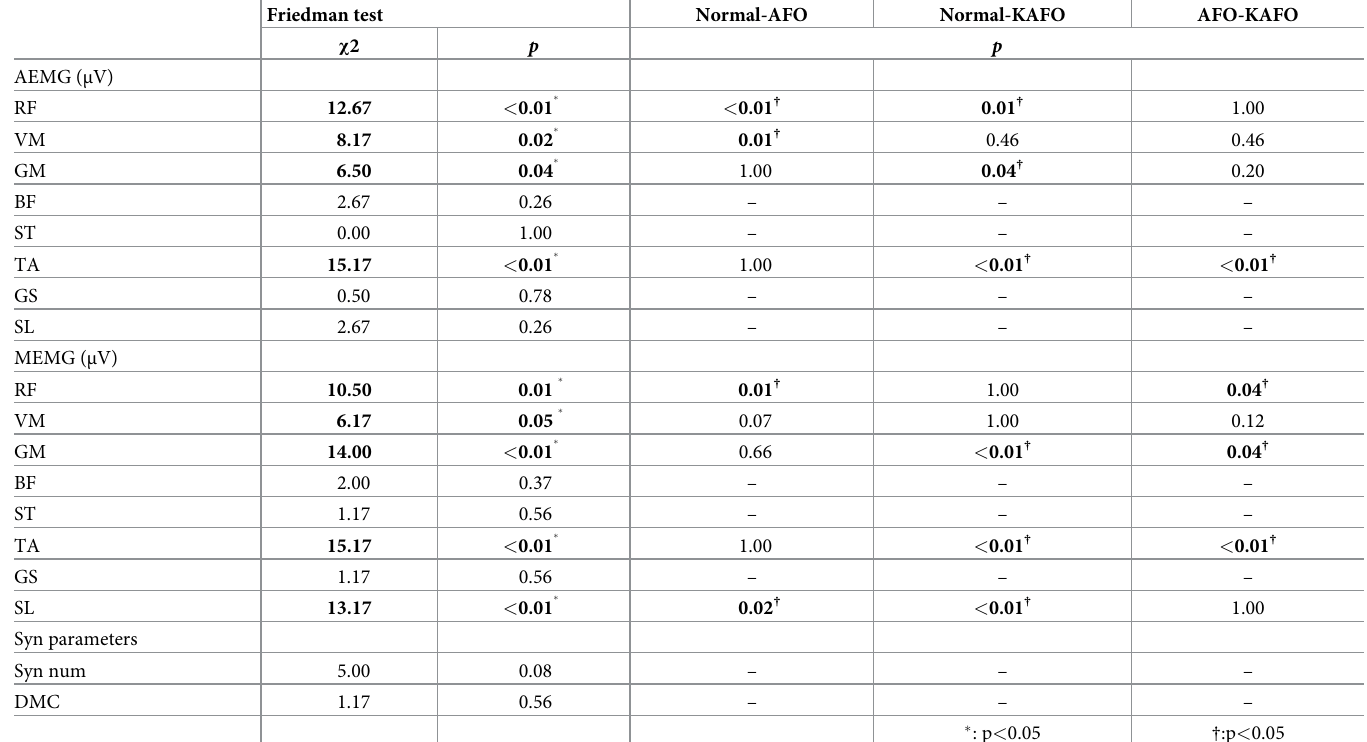
– – – � : p < 0.05 †:p < 0.05 The results of the Friedman test and post hoc analysis for the averaged and maximum EMG values. Asterisks represent significant differences (p < 0.05) among the three conditions using the Friedman test. Daggers indicate a significant difference (p < 0.05) between each condition revealed by post hoc